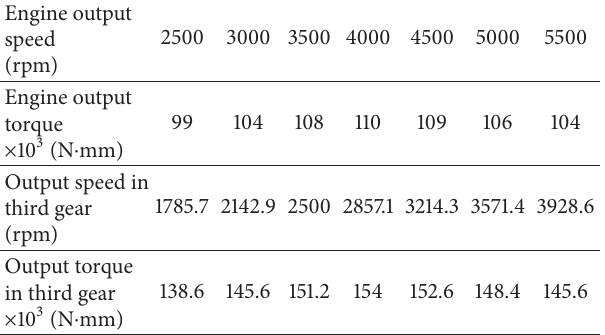
Table 5: Drive shaft input speed/torque matching